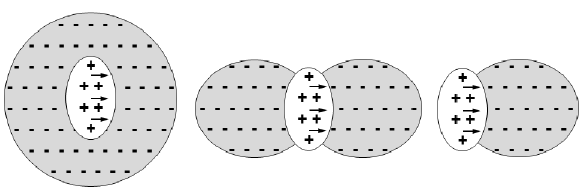
Figure 1: A coarse approximation of possible RFs examples that address center-surround antagonism. MT receptive field models consisting of concentric excitatory center (light shading and “+” signs) and inhibitory surround regions (dark shading and “-” signs). Arrows indicate the cell’s preferred direction of motion. Three ex- amples of different kinds of surround organization are